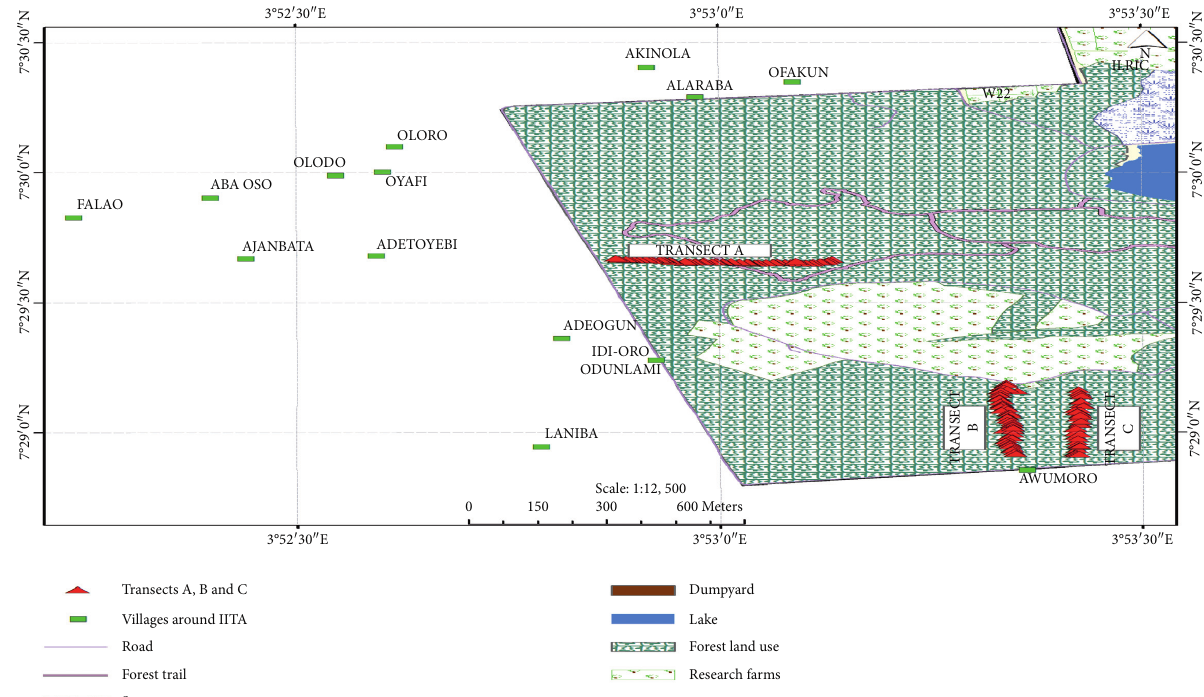
Figure 2: Map of west bank forest showing the location of transects A , B , and C .